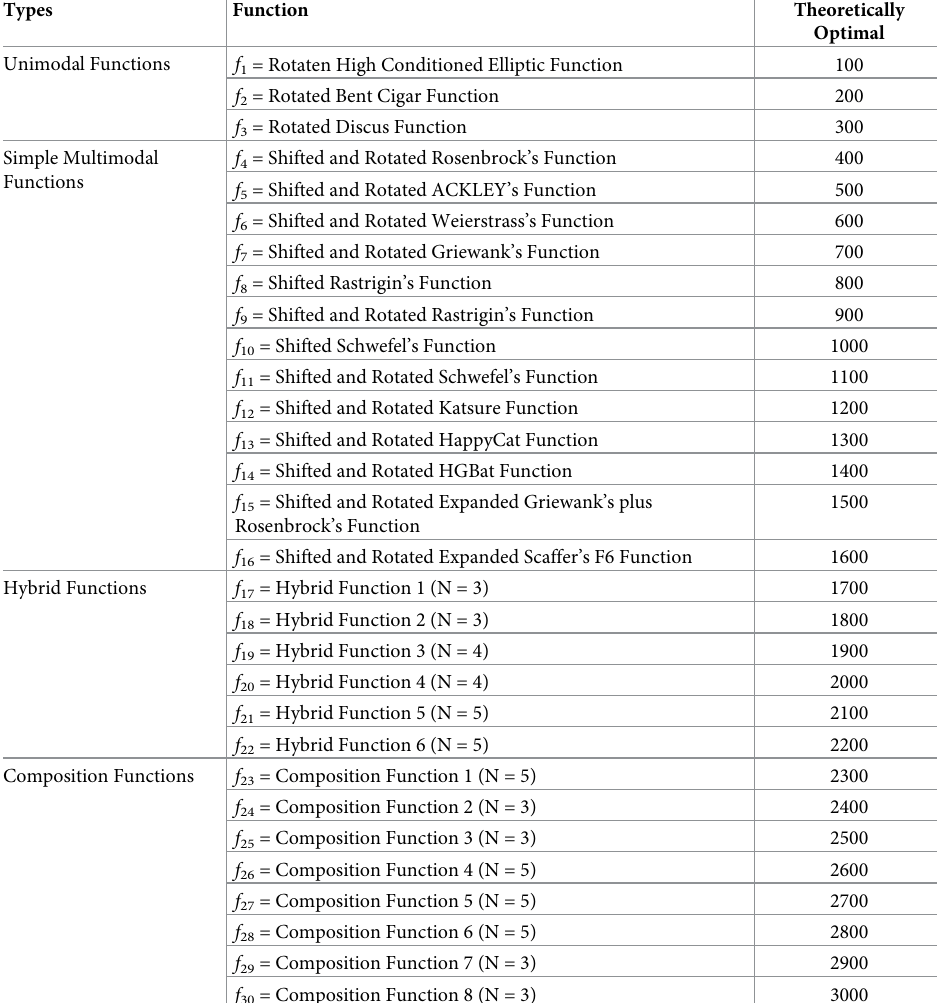
Table 1. Experimental functions, the CEC 2014 benchmark functions, the search range for each function is (-100,100) [38].